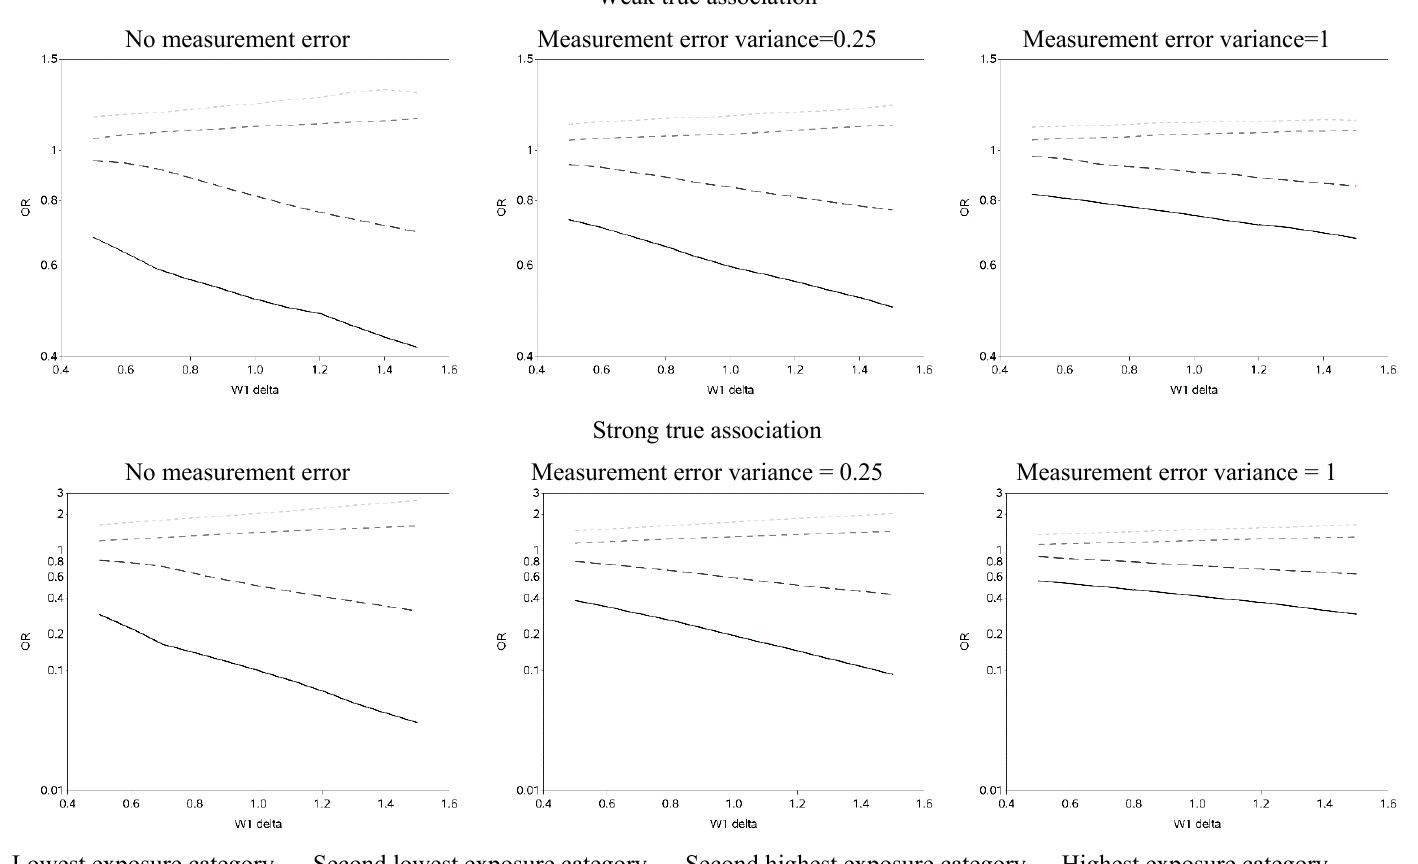
Figure 3 ． Odds ratios (OR) for different cutoffs used to create 5 categories for the causal yet mismeasured exposure (W 1 ) (δ is identified as “W1 delta” in the figure). The 4 W1 cutoffs were centered at 0 with δ from 0.5 to 1.5 standard deviations, in increments of 0.1. Reference category for W1 is mean +/− (0.5 × δ × standard